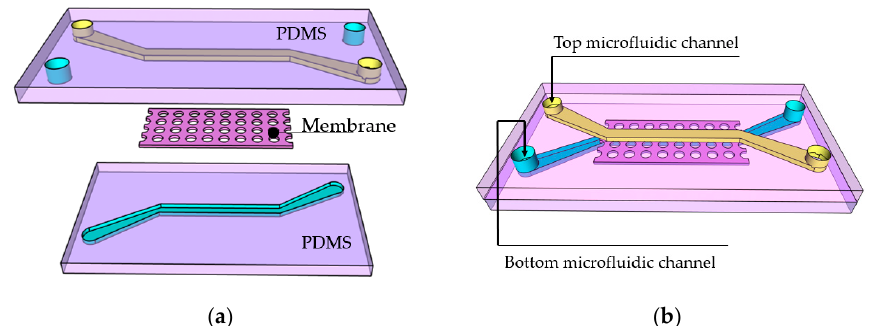
Figure 1. Layer-by-layer ( a ) and combined to a chip ( b ) 3D visualization of a microfluidic structure including membranes.